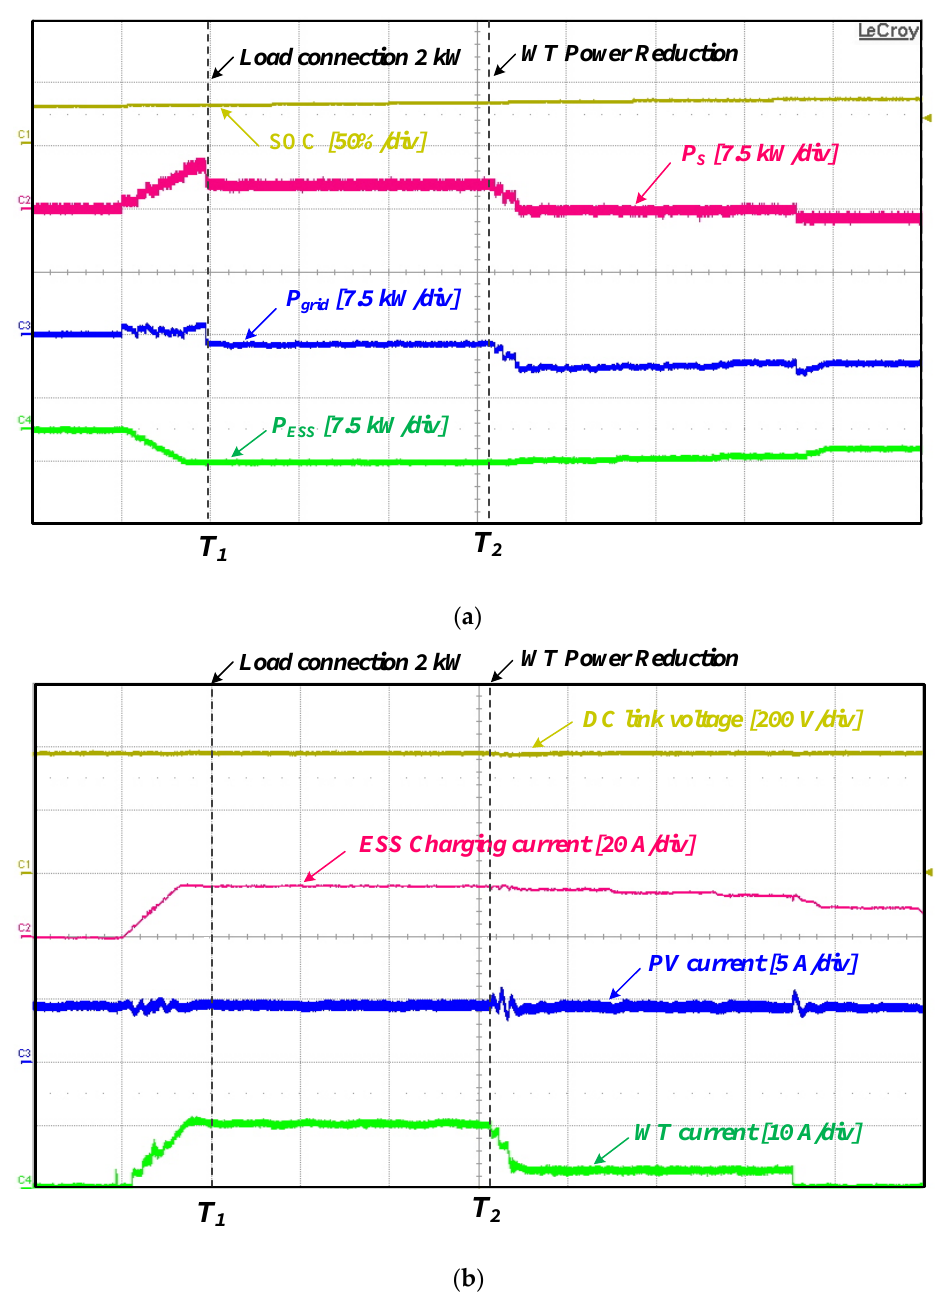
Figure 20. Experiment waveforms of operation mode 1 ( a ) ANN input/output data waveform, ( b ) Voltage and current waveforms in major parts. Table 4. Power flow of each power converter in operation mode 1.